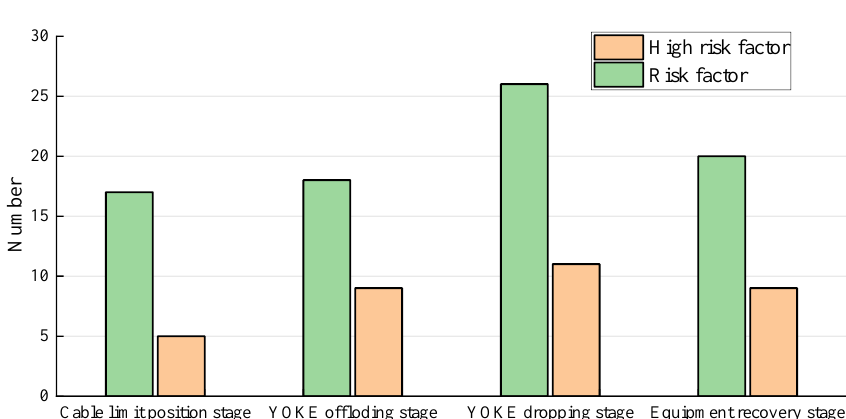
Figure 5. Comparison of the number of risk factors and high-risk factors for each operational stage.